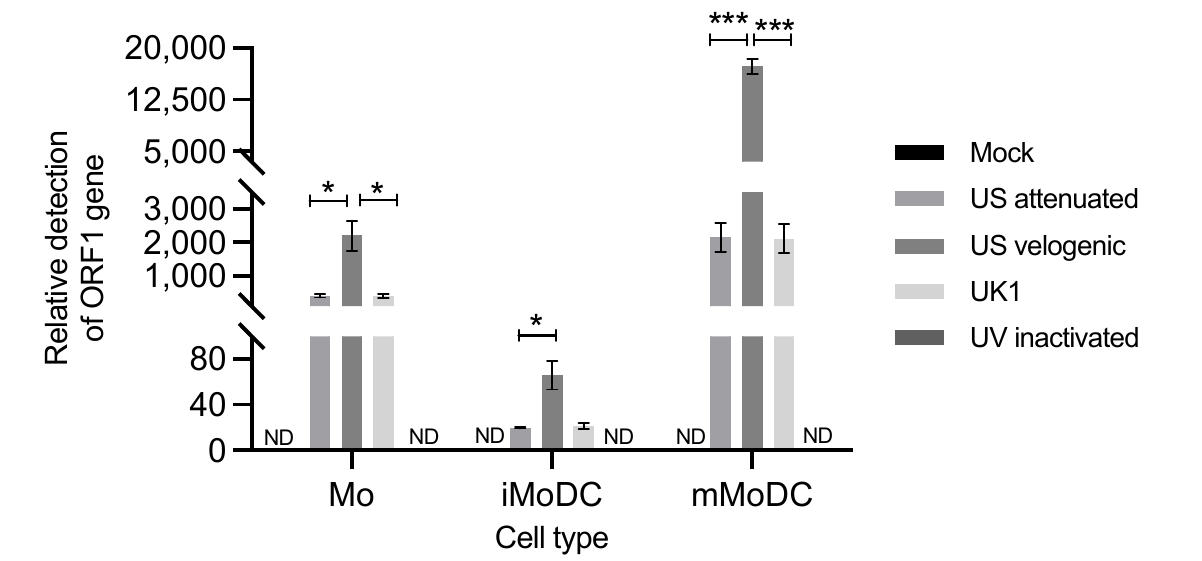
Figure 1. Detection of viral replication in equine Mo and MoDC by qPCR targeting the ORF1 region of EAV. Horse Monocytes, immature MoDC (iMoDC) and mature MoDC (mMoDC) were inocu- lated at MOI 5 with different preparations of replicative or UV inactivated EAV. RNA was extracted from cells 16 hpi, reverse transcribed into cDNA and EAV replication quantified by qPCR, using 18S rRNA gene as the reference gene. The normalized fold difference ratio was calculated using the 2- ΔΔ Ct formula with 0 hpi as the comparator. Results were represented as the average fold differ- ence ± SEM ( n = 9). ND represents no viral detection in mock and UV inactivated infected cells. Statistical significance was determined using a 2-way ANOVA with Bonferroni post-test to compare replicate means. * and *** indicate significant differences between sample means where p < 0.005 or 0.0001, respectively.